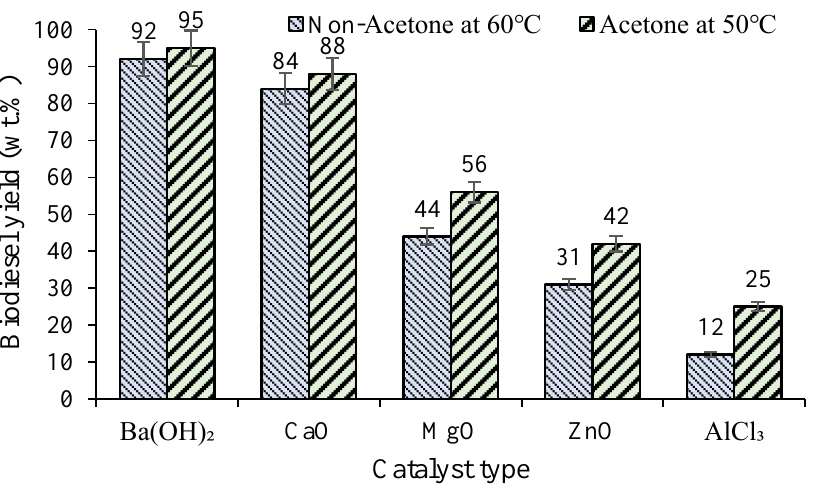
Figure 8. Effect of cosolvent on biodiesel yield (catalyst amount 5 wt.%; methanol-to-oil molar ratio of 12:1; acetone content of 20 vol%; time 120 min, speed 600 rpm).